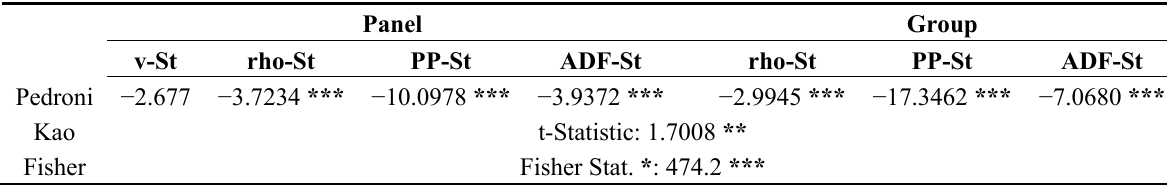
Table 3. Panel cointegration tests.